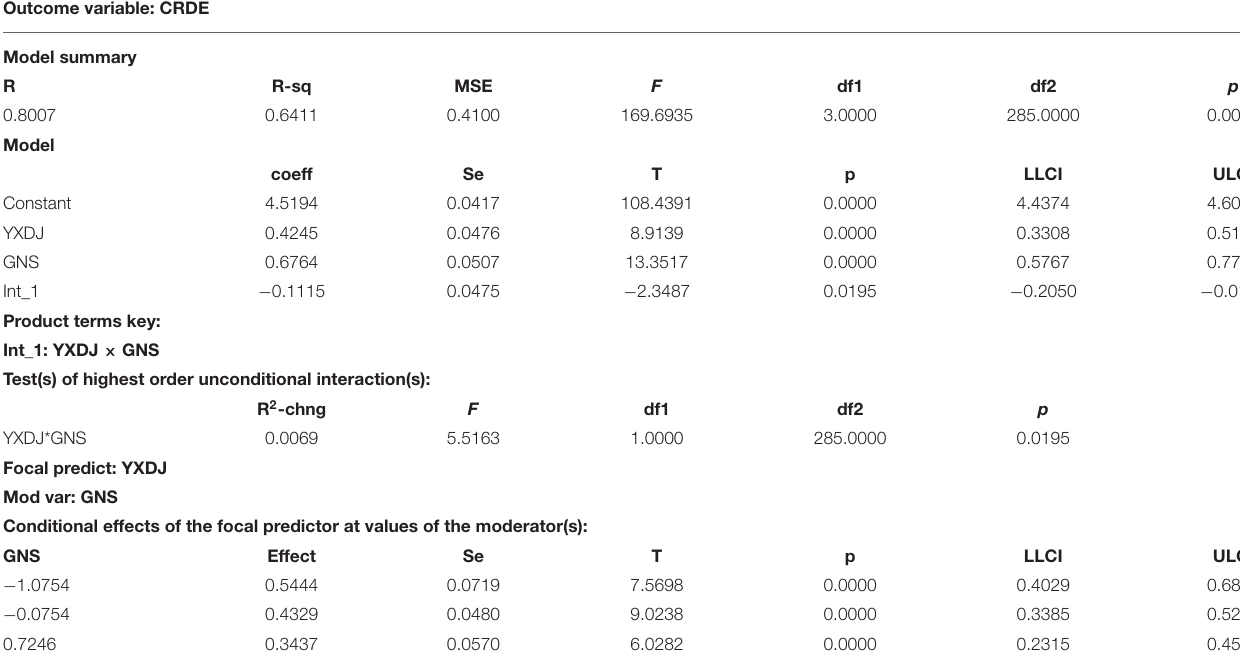
TABLE 13 | Test results of GNS moderating effect.